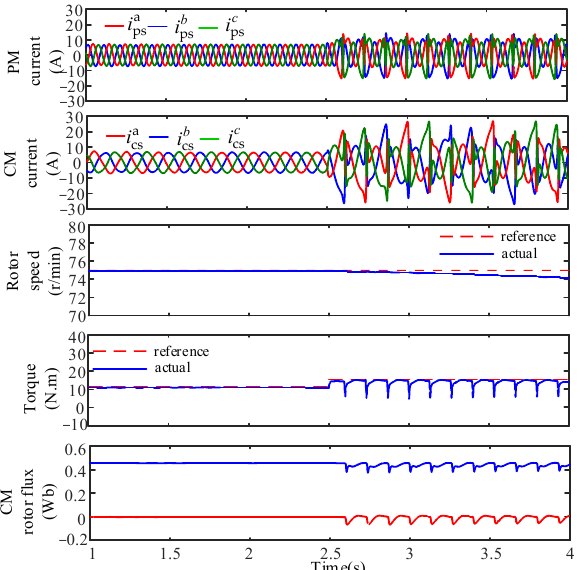
Figure 14. Simulation results of load boundary verification.